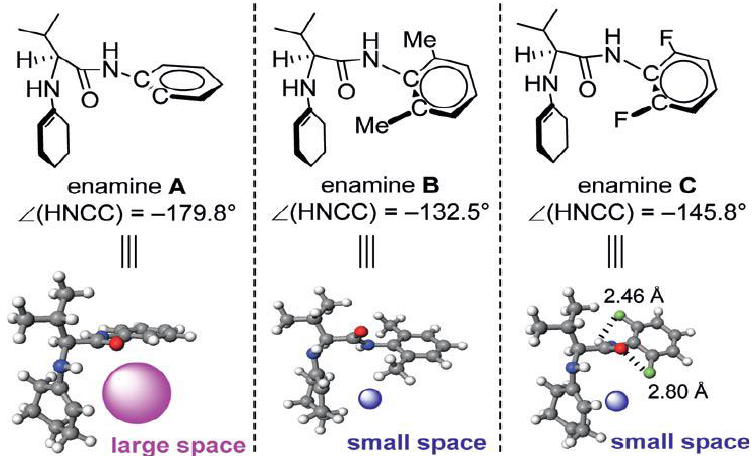
Figure 6. Enamine structures calculated at the B3LYP/6-31G(d,p) level.